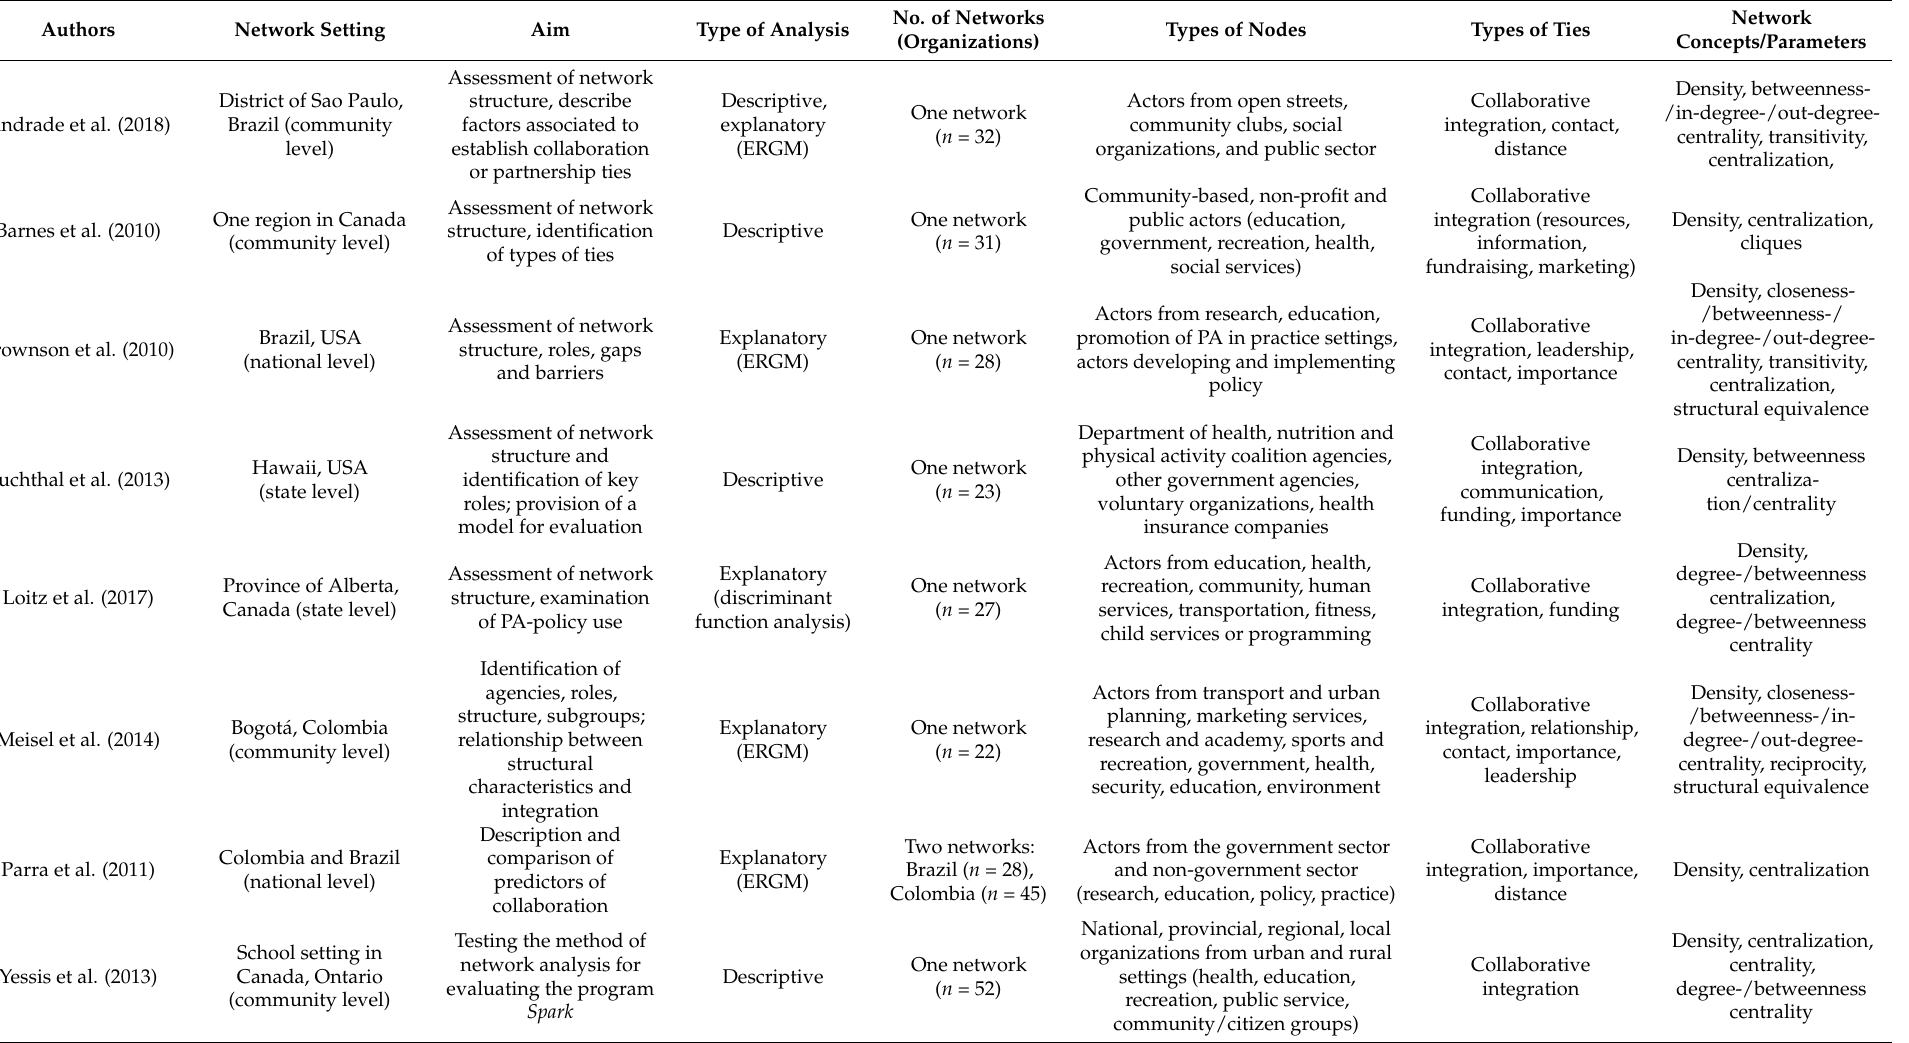
Table 1. Data extraction for included